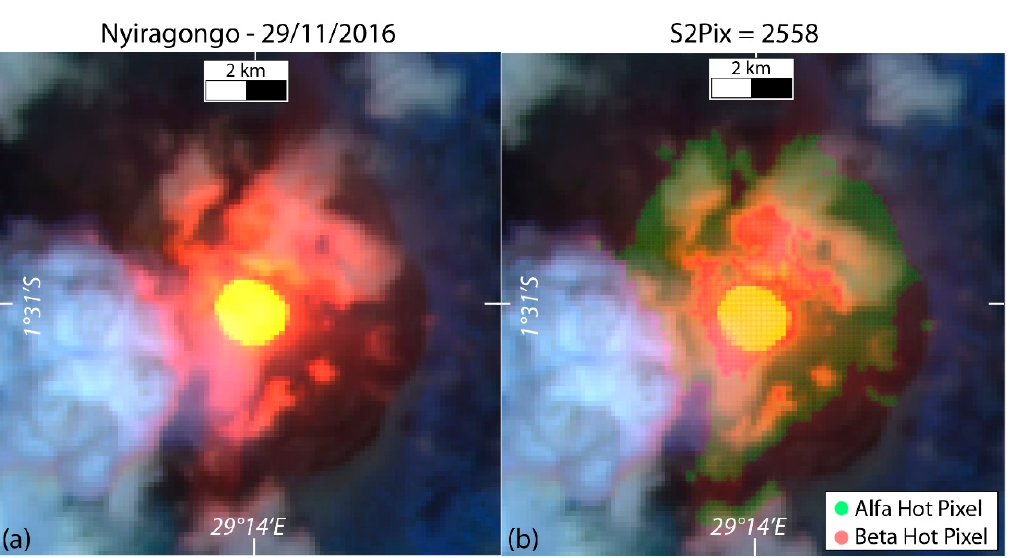
Figure 14. Limits of algorithm detection. ( a ) SENTINEL-2 RGB image (12-11-8a bands analysis), over Nyiragongo lava-lake volcano, 29/11/2016; ( b ) application of detection algorithm at the same image, in which green area represent the α -triggered pixels and red area represent the β -triggered pixels.